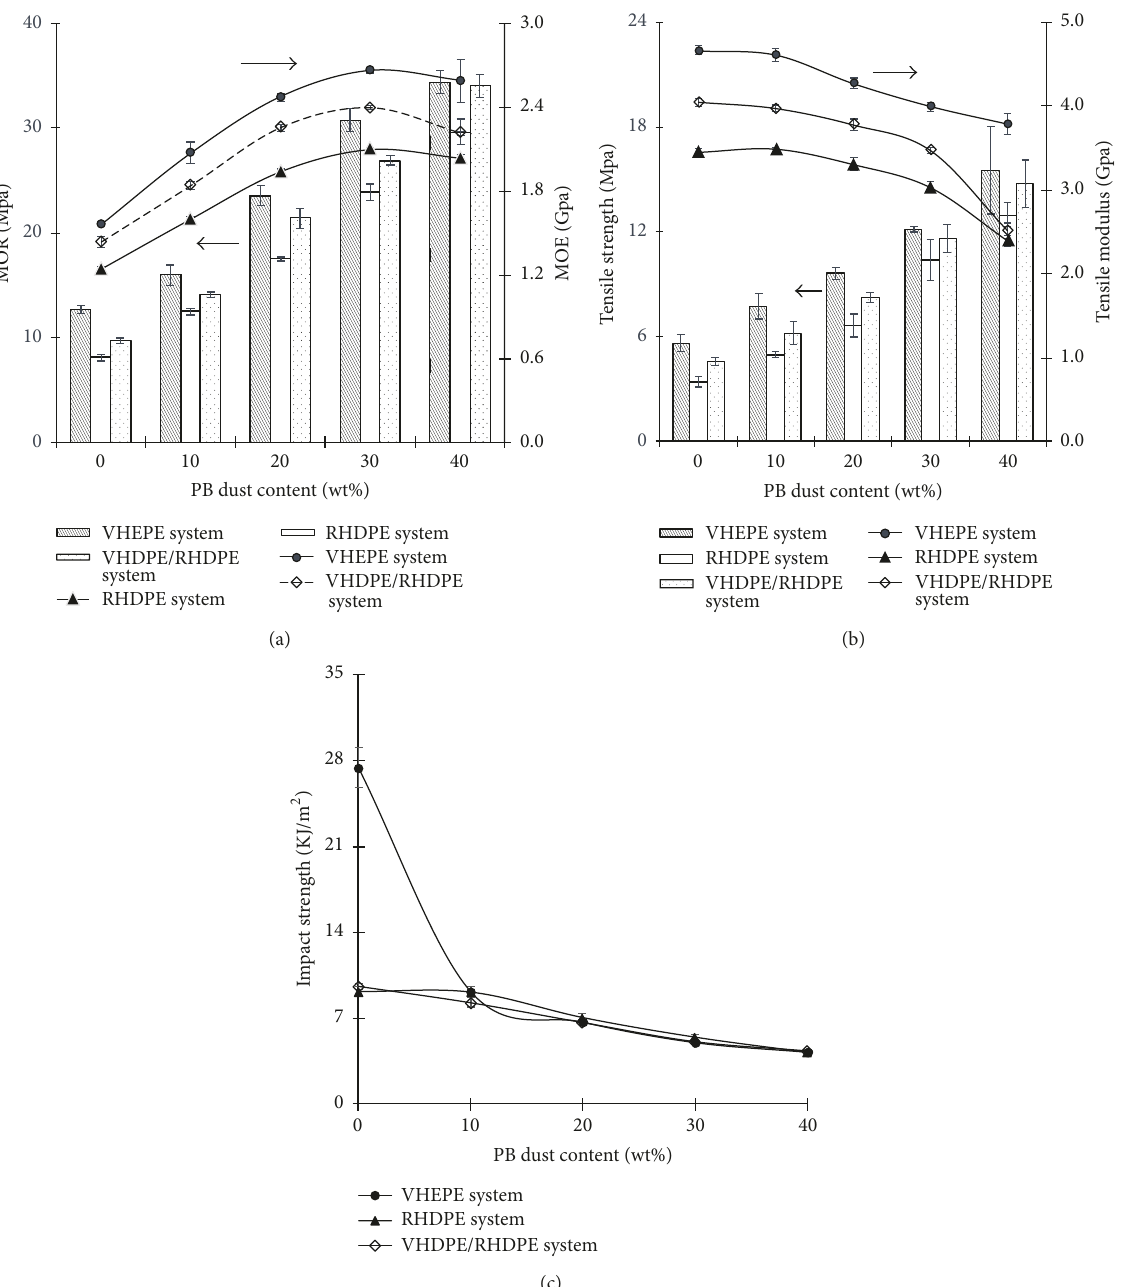
Figure 2: Mechanical properties of PB dust/HDPE composite: (a) flexural properties, (b) tensile properties, and (c) impact properties.